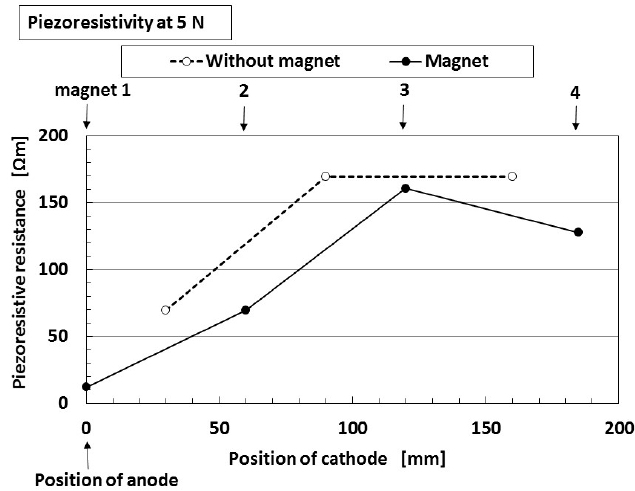
Figure 19. Change in the piezoresistance by the position of the cathode for wet-type MCF rubber solar cell electrolytically polymerized under a magnetic field: “without magnet” indicates the position between the regions that are influenced by the permanent magnet at electrolytic polymerization; “with magnet” indicates the position influenced by the permanent magnet at electrolytic polymerization. In the figure, positions 1–4 of the applied magnet at electrolytic polymerization are also shown. The ordinate in the figure presents specific resistance values at non-irradiation.